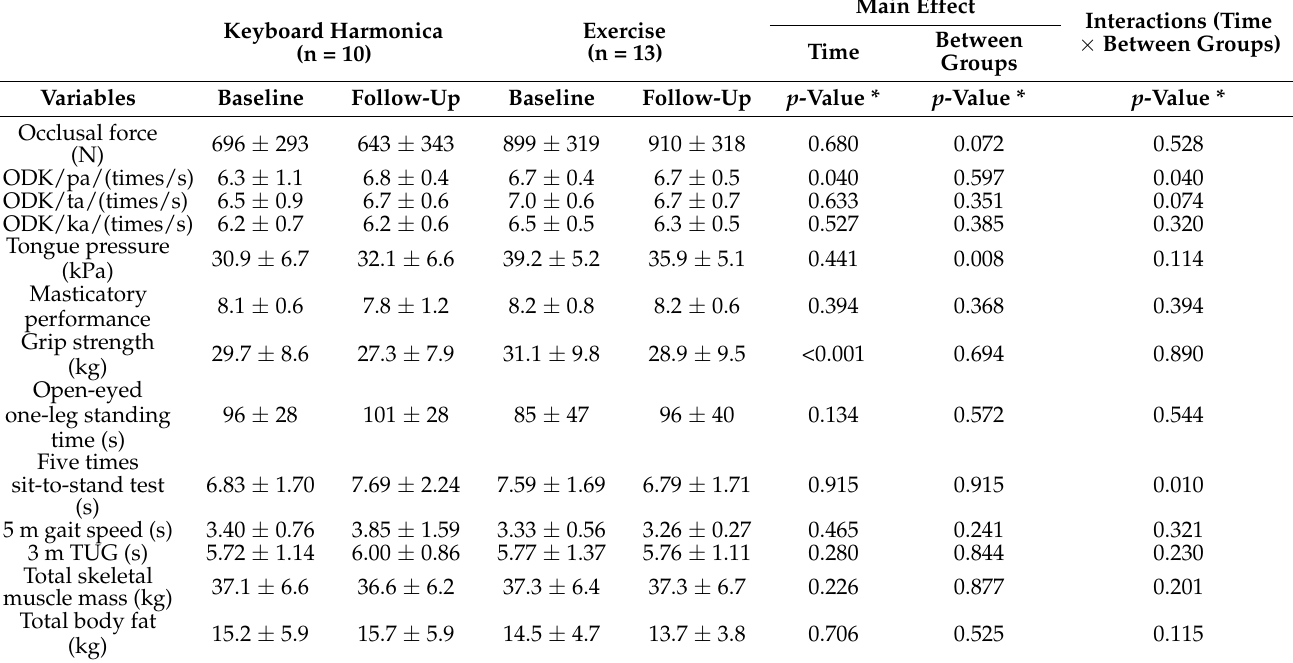
Table 2. Comparison between the keyboard harmonica and exercise groups at baseline and